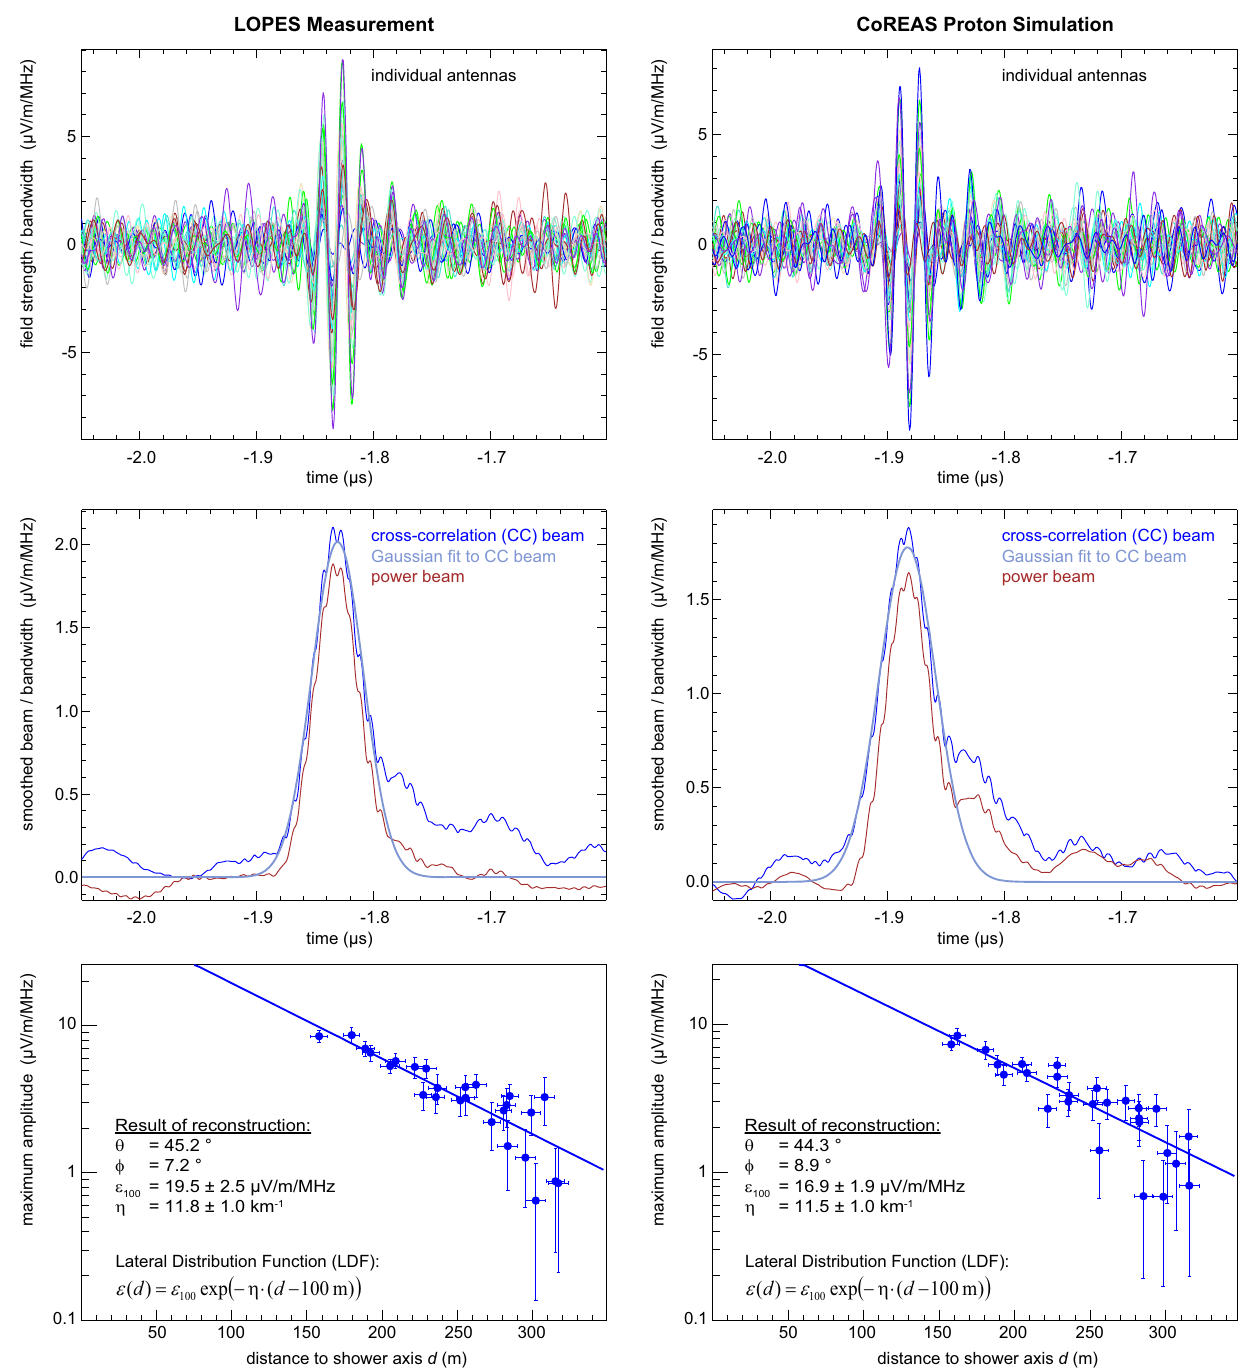
Fig. 5 Example event measured by LOPES and simulated with CoREAS using the KASCADE-Grande reconstruction as input: energy E = 3 . 4 × 10 17 eV, azimuth φ = 8 . 6 ◦ , zenith θ = 44 . 1 ◦ . This event is a best case example with high signal-to-noise ratio. Therefore, the sig- nal is easily visible in all antennas. Left: LOPES measurement. Right: CoREAS end-to-end simulation including the detector response. Top: